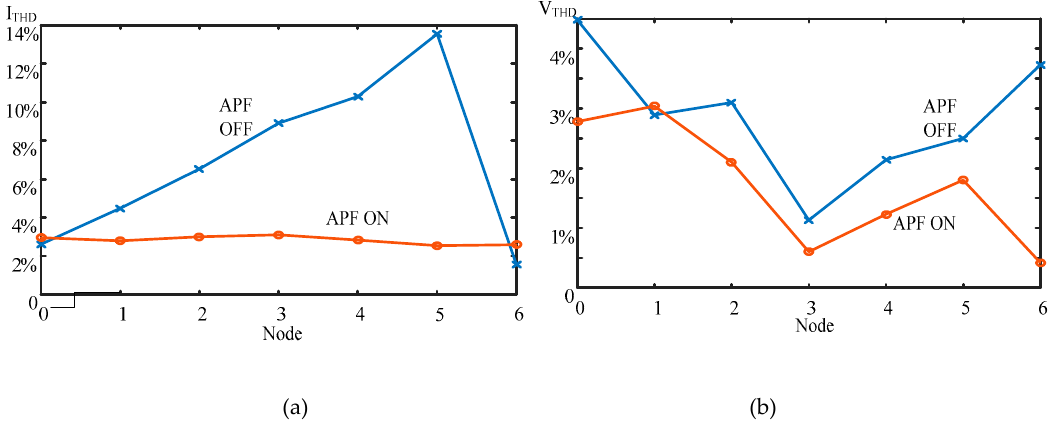
Figure 15. THD at nodes between bus 17 and bus 18 of the IEEE 33-bus distribution system: ( a ) current, and ( b ) voltage.